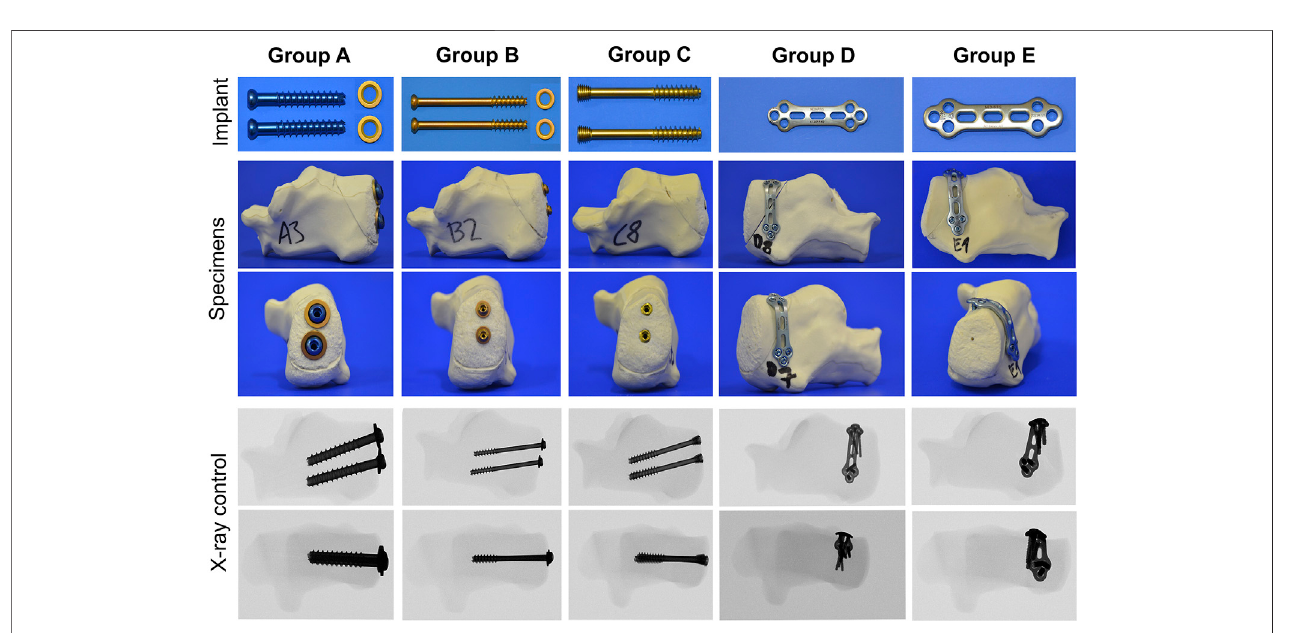
FIGURE 3 | Overview of the fi xation techniques tested, including the implant material, stabilized synthetic bones, and fl uoroscopic imaging.